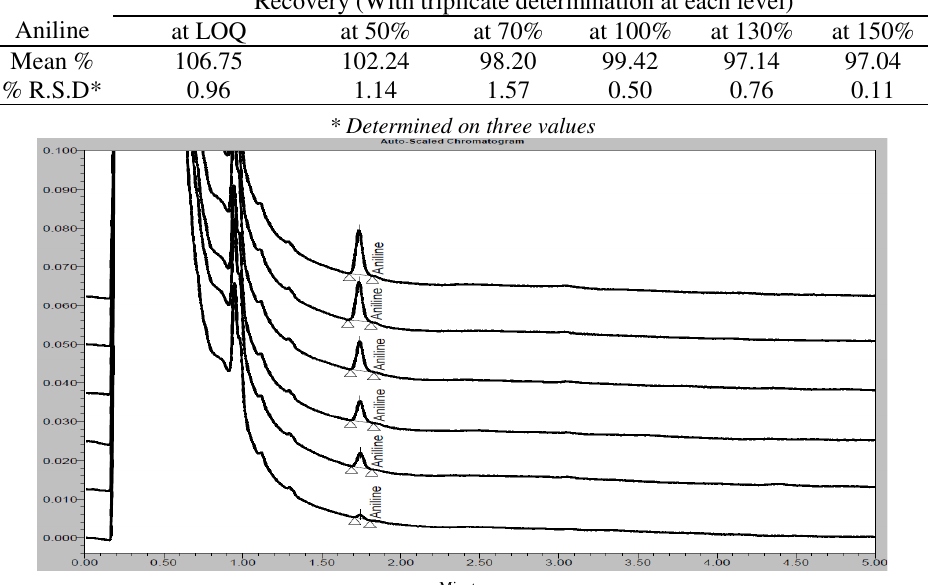
Figure 7. Overlay chromatogram of accuracy study at LOQ, 50, 70, 100, 130 and 150%. LOD and LOQ